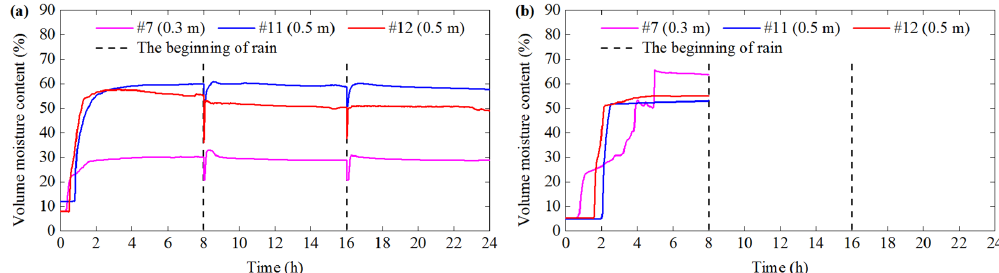
Figure 11. Volume moisture content at position D and E of (a) test 5 and (b) test